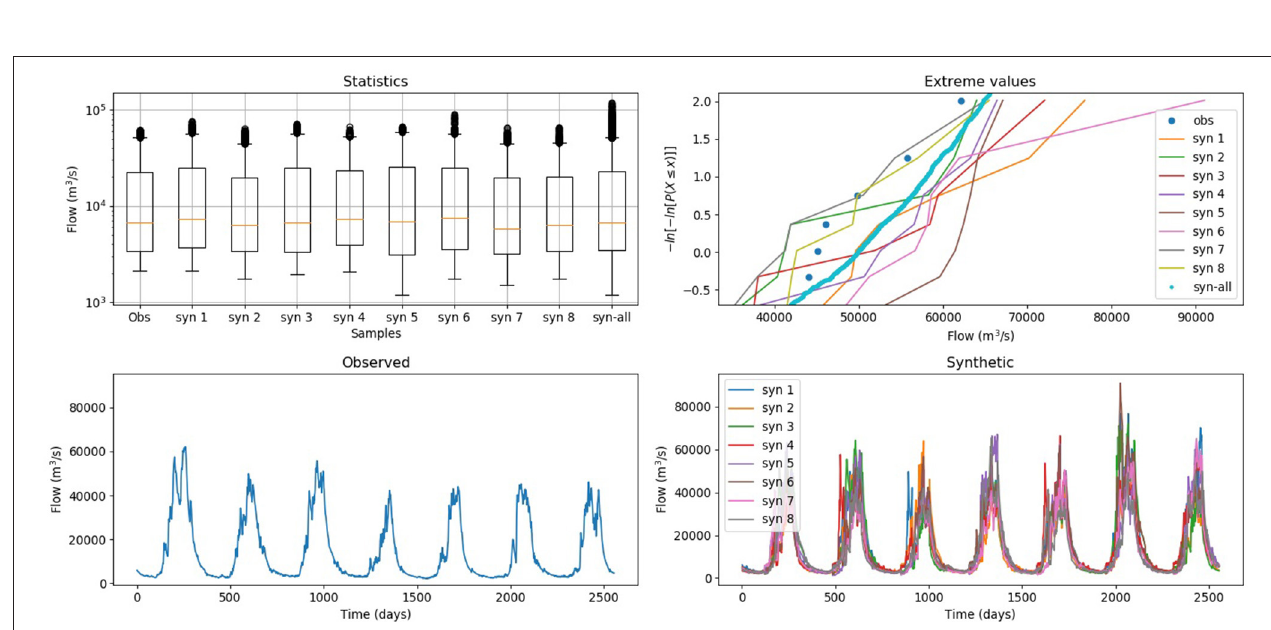
FIGURE 17 | Several representations of synthetic flow time series are generated based on seven years of observed discharge data, and their corresponding statistic and extreme